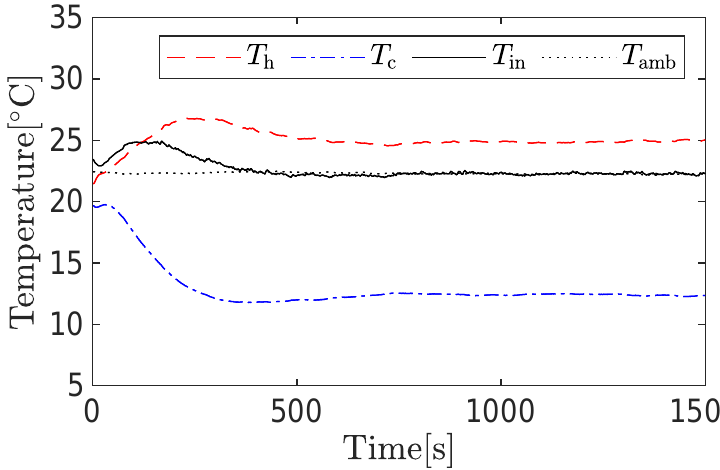
Figure 11. Temperature of T in , T amb , T h , T c (w/o operator theory).